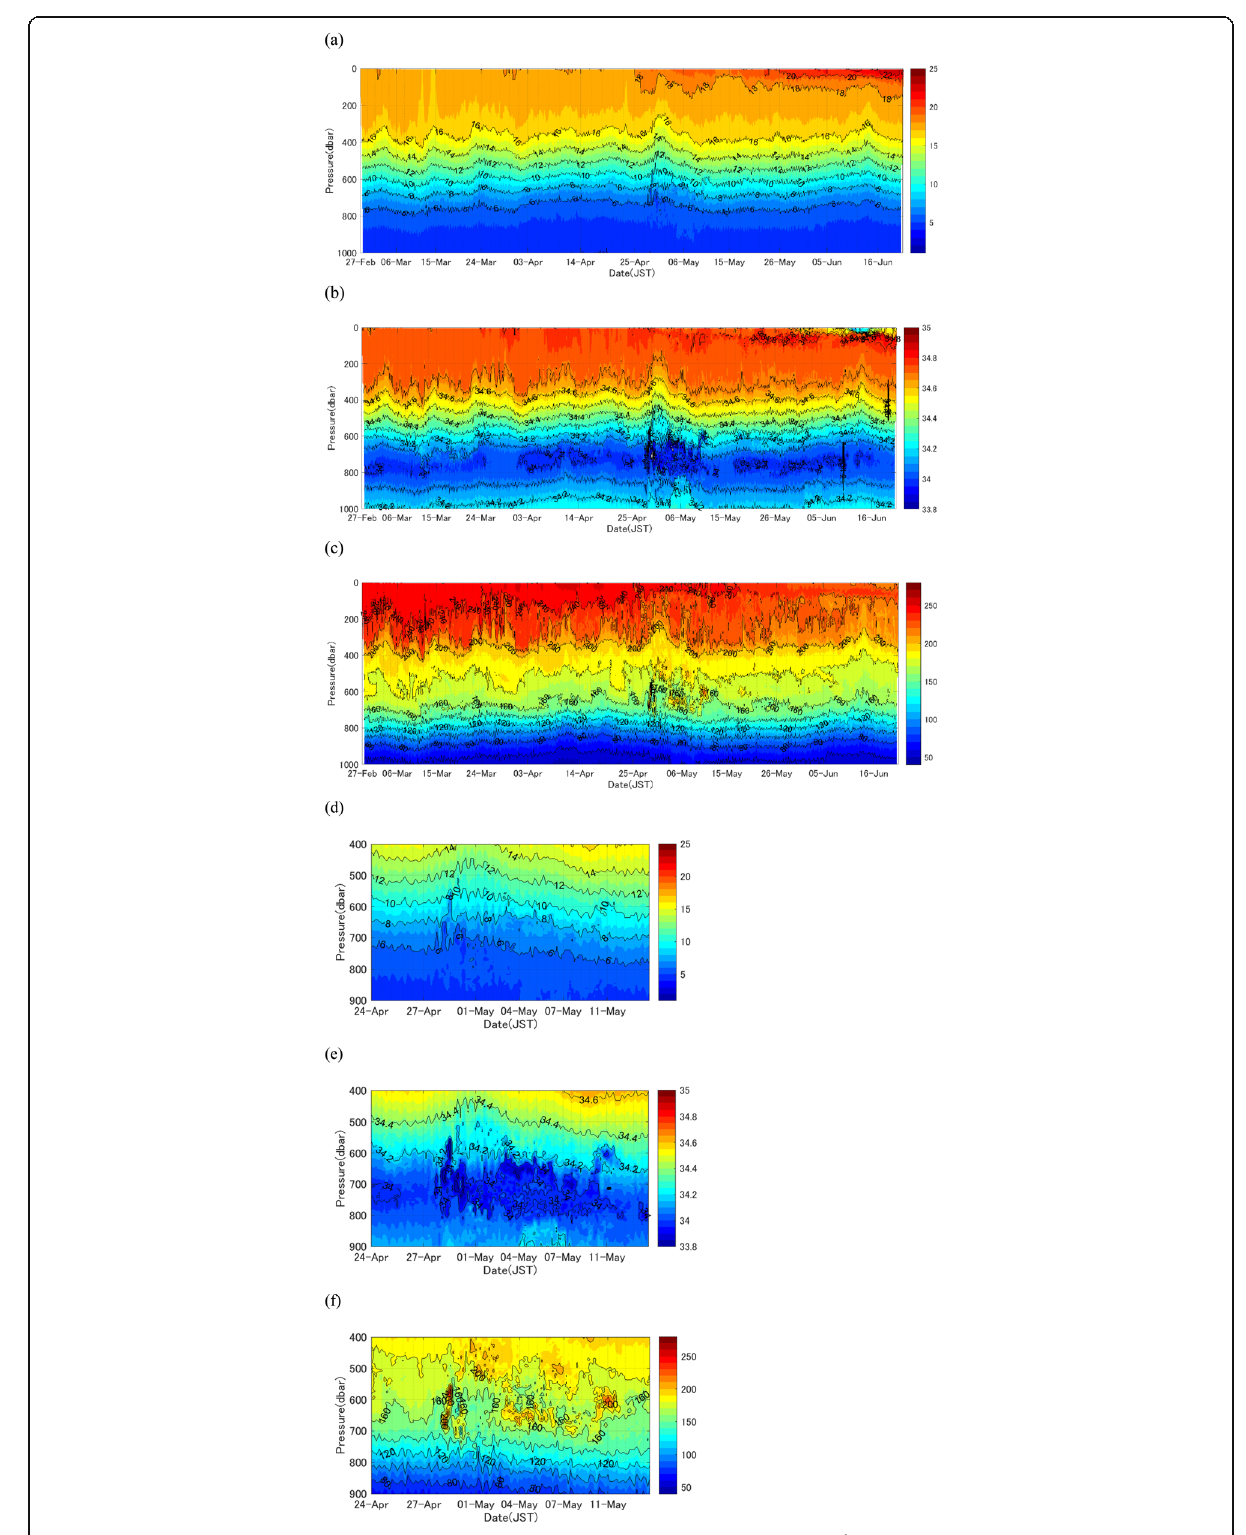
Fig. 3 Time series of a temperature (°C), b salinity (PSS-78), and c dissolved oxygen (DO) ( μ mol kg − 1 ) during the whole observation period (Feb. 27 – Jun. 21, 2014) with contour intervals of 1 °C, 0.2, and 20 μ mol kg − 1 , respectively. Enlarged figures of d temperature, e salinity, and f DO with contour intervals of 1 °C, 0.2, and 20 μ mol kg − 1 ,